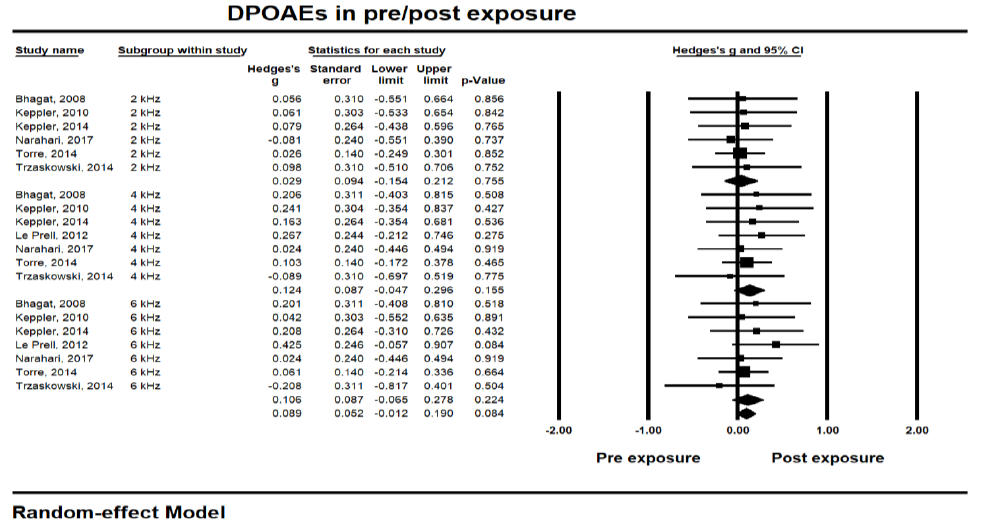
Figure 3. Short-term hearing changes in distortion product otoacoustic emissions (DPOAEs) amplitude at 2, 4, and 6 kHz center frequencies within 24 h after music exposure.